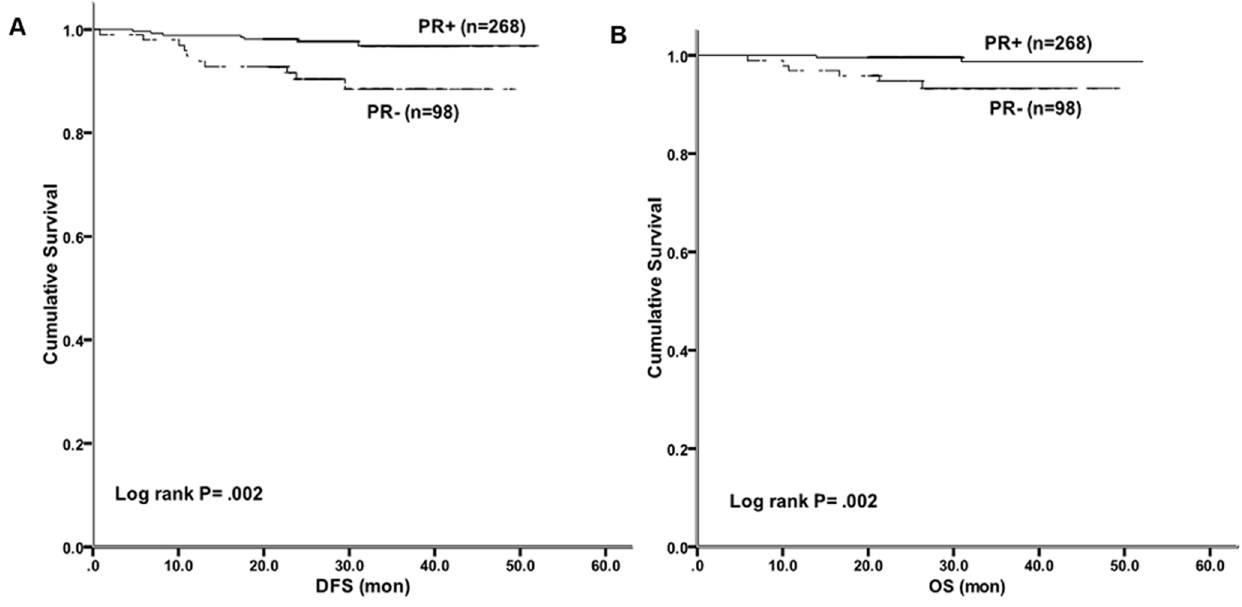
Figure 1. Disease-free survival and overall survival by PR status among Luminal B/HER2- patients. (A) The 2-year DFS was significantly better in the PR-positive group than in the PR-negative group (97.7% Vs 90.4%, Log-rank p=.002). (B) A poorer 2-year OS was also detected in PR- negative group (99.6% Vs 94.8%, Log-rank p=.002).